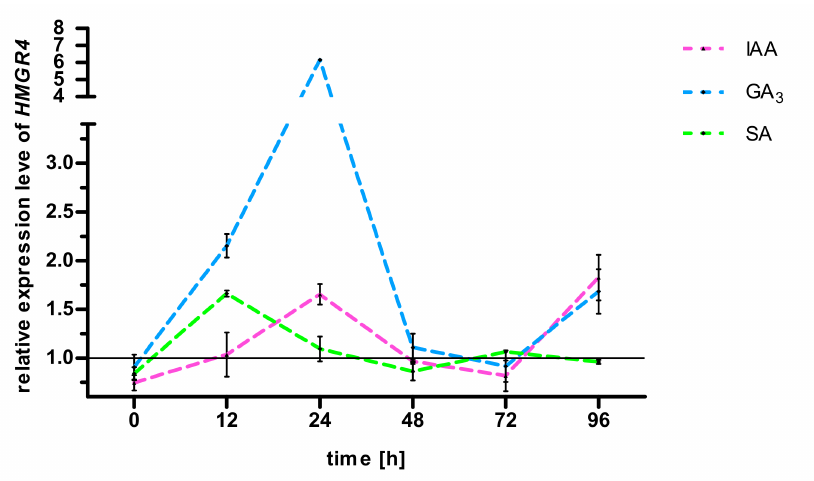
Figure 1. Effect of GA 3 , IAA and SA on HMGR4 gene expression in S. miltiorrhiza leaves. The expression was analysed by real-time PCR. The results are presented as mean ±